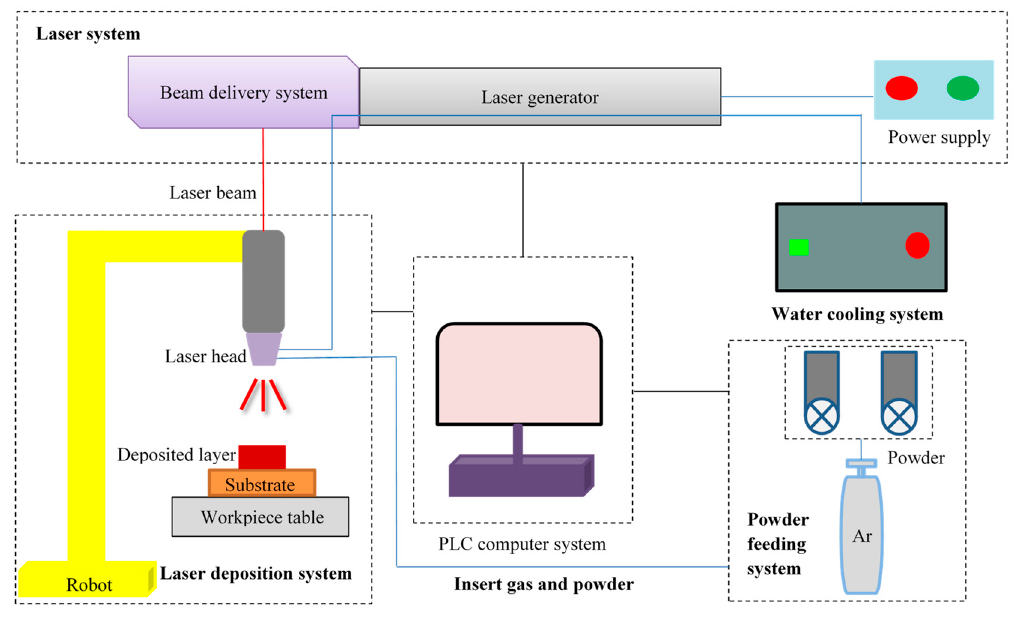
Figure 1. Laser cladding system.